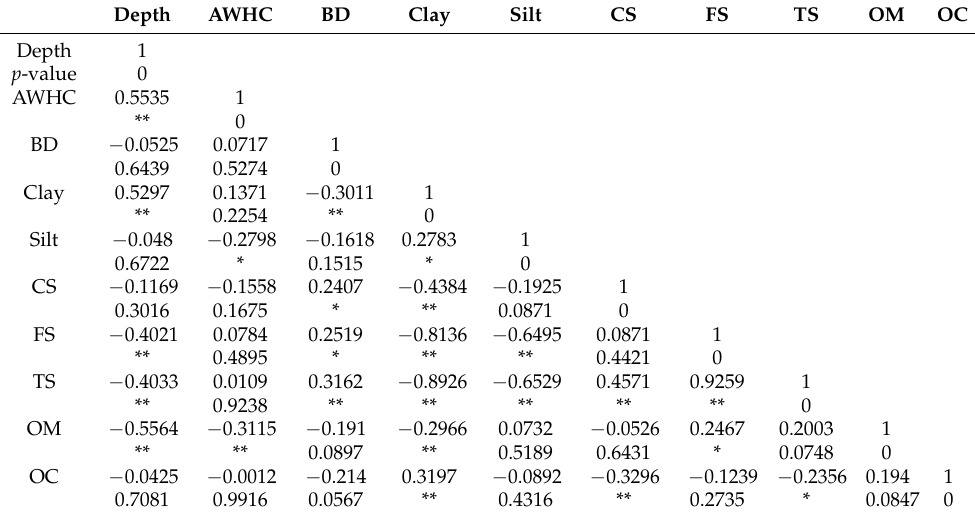
Table 2. Relationships between each of the soil variables with AWHC. Depth AWHC BD Clay Silt CS FS TS